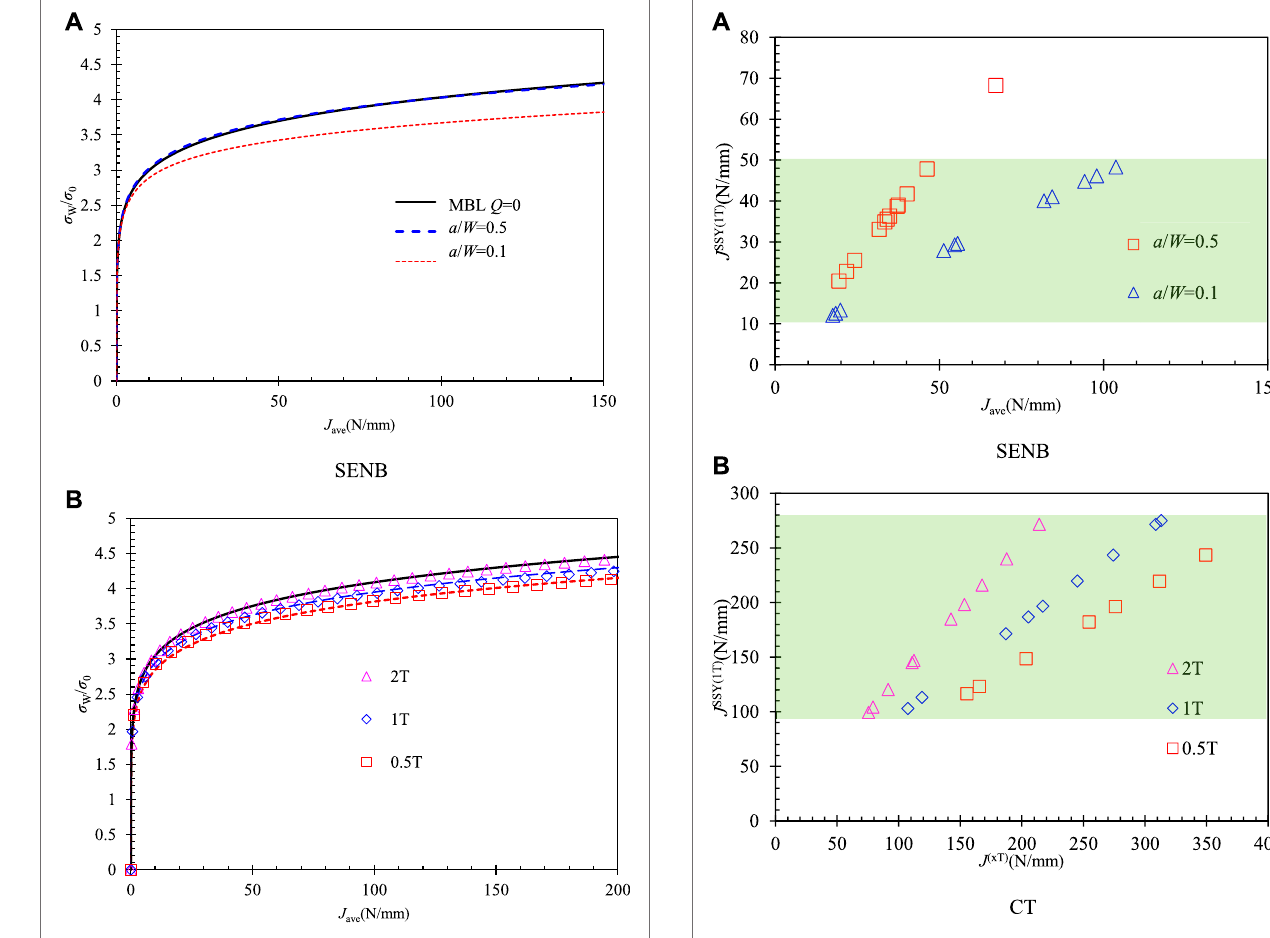
FIGURE 11 | Corrected fracture toughness to J SSY from the average values of SENB and CT specimens on the local approach. (A) SENB. (B) CT.